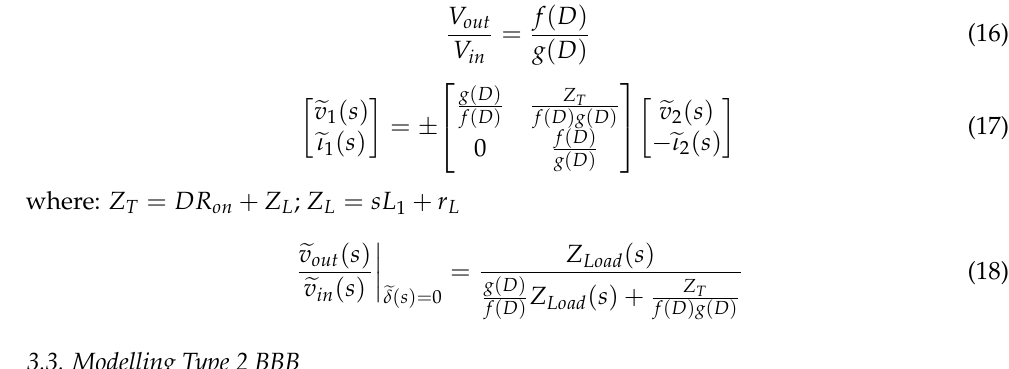
s DD  − Figure 8. Rail connection variants for the ideal lumped Type 2 BBBs. ( a ) Switch and diode to rail, ( b ) inductor and switch to rail, and ( c ) inductor and diode to rail.